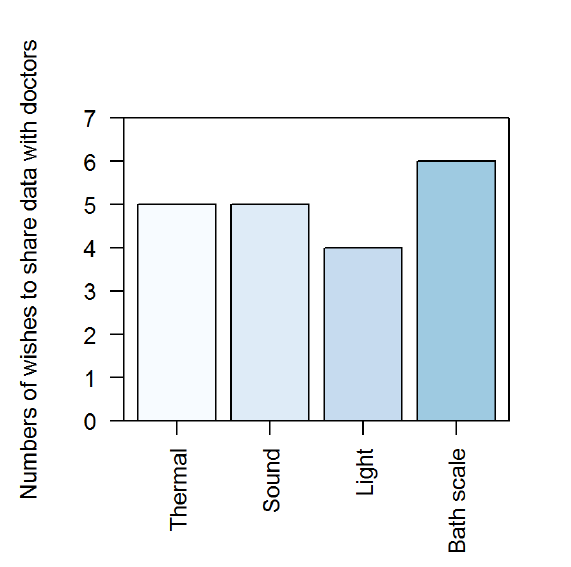
Figure 5. Numbers of end users intentions to share data with their general practitioner